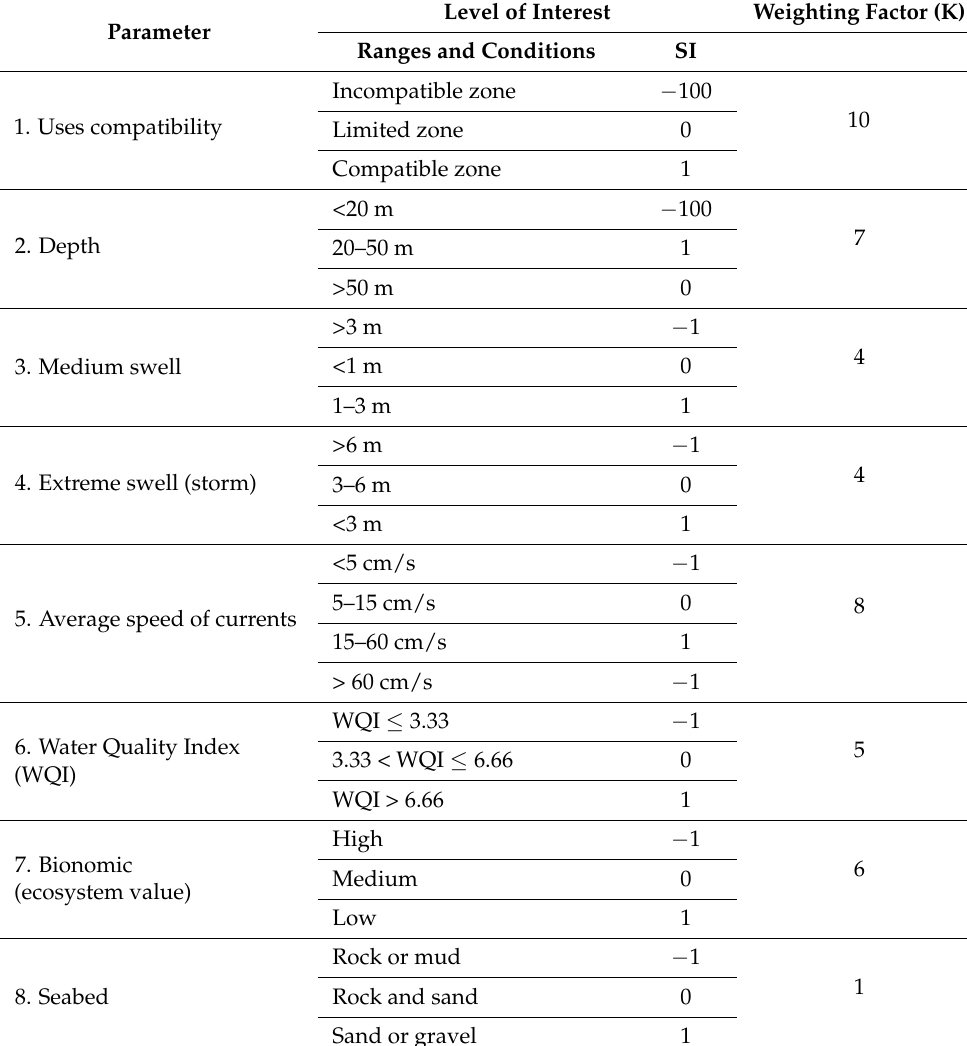
Table 2. Parameters and ranges used for calculating the Degree of Compatibility for the AZA designation were focused on finfish farming (adapted from